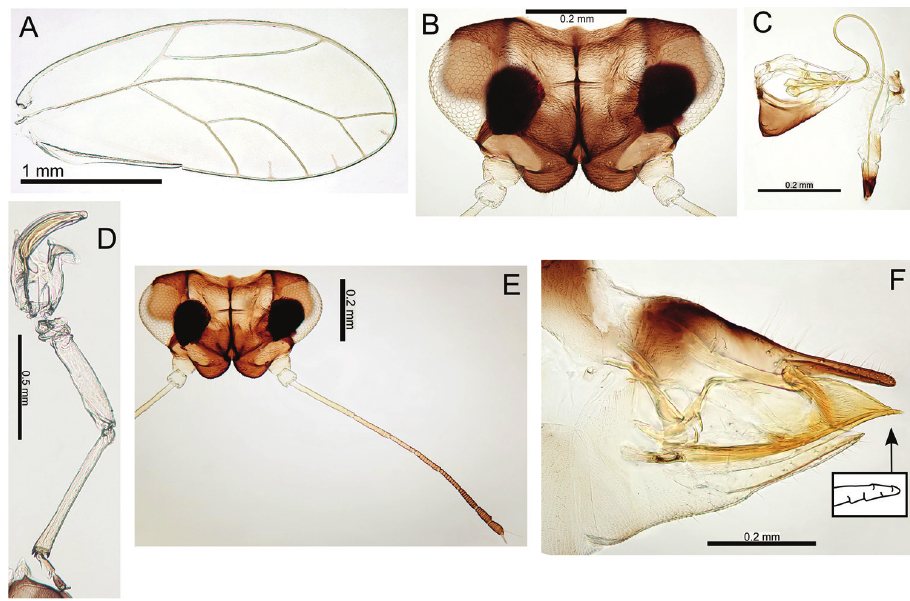
Figure 10. Pariaconus kapo sp. n. (female) A fore wing B head (uncleared ocular tissue) C proboscis D hind leg E head and antenna F terminalia (ovipositor serrations